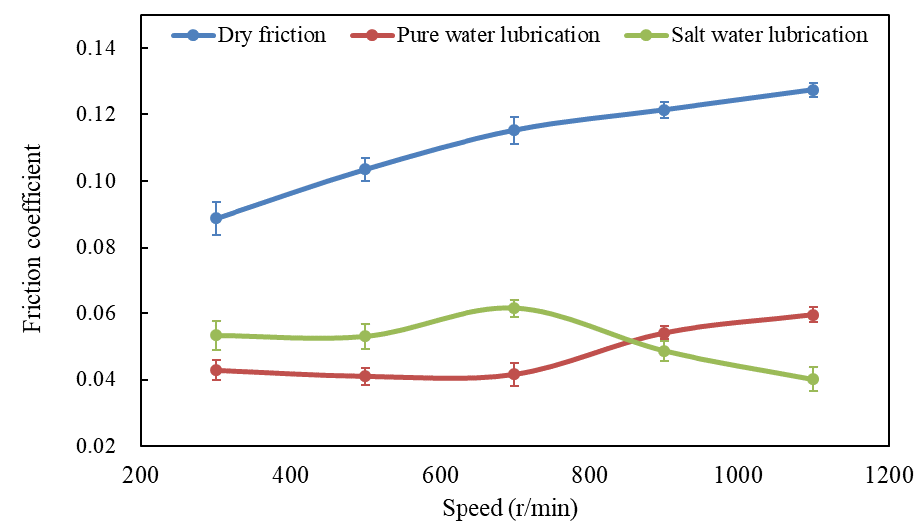
Figure 8. Variation of friction coefficient with speed under different friction conditions.